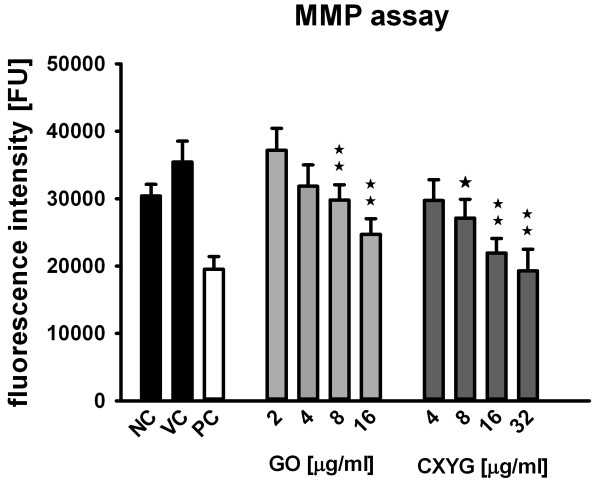
Mitochondrial membrane potential upon exposure to GO and CXYG. Hep G2 cells were exposed to increasing concentrations of GO (grey bars) or CXYG (dark grey bars) for 72 h. GO and CXYG suspensions were prepared by diluting aqueous stock suspensions in medium supplemented with 10% FBS. The vehicle control (VC) consisted of 10% (v/v) Milli-Q water in medium. Cells incubated with only medium served as negative control (NC) (black bars). FCCP (20 μM, 10 min) was used as positive control (PC) (white bar). Bars represent the mean and standard error of the mean (SEM) of three independent repetitions. Statistically significant differences with respect to the vehicle control (one-way rmANOVA, Dunnett´s Post-hoc test) are indicated as followed: ☆ p < 0.05, ☆☆ p < 0.01.